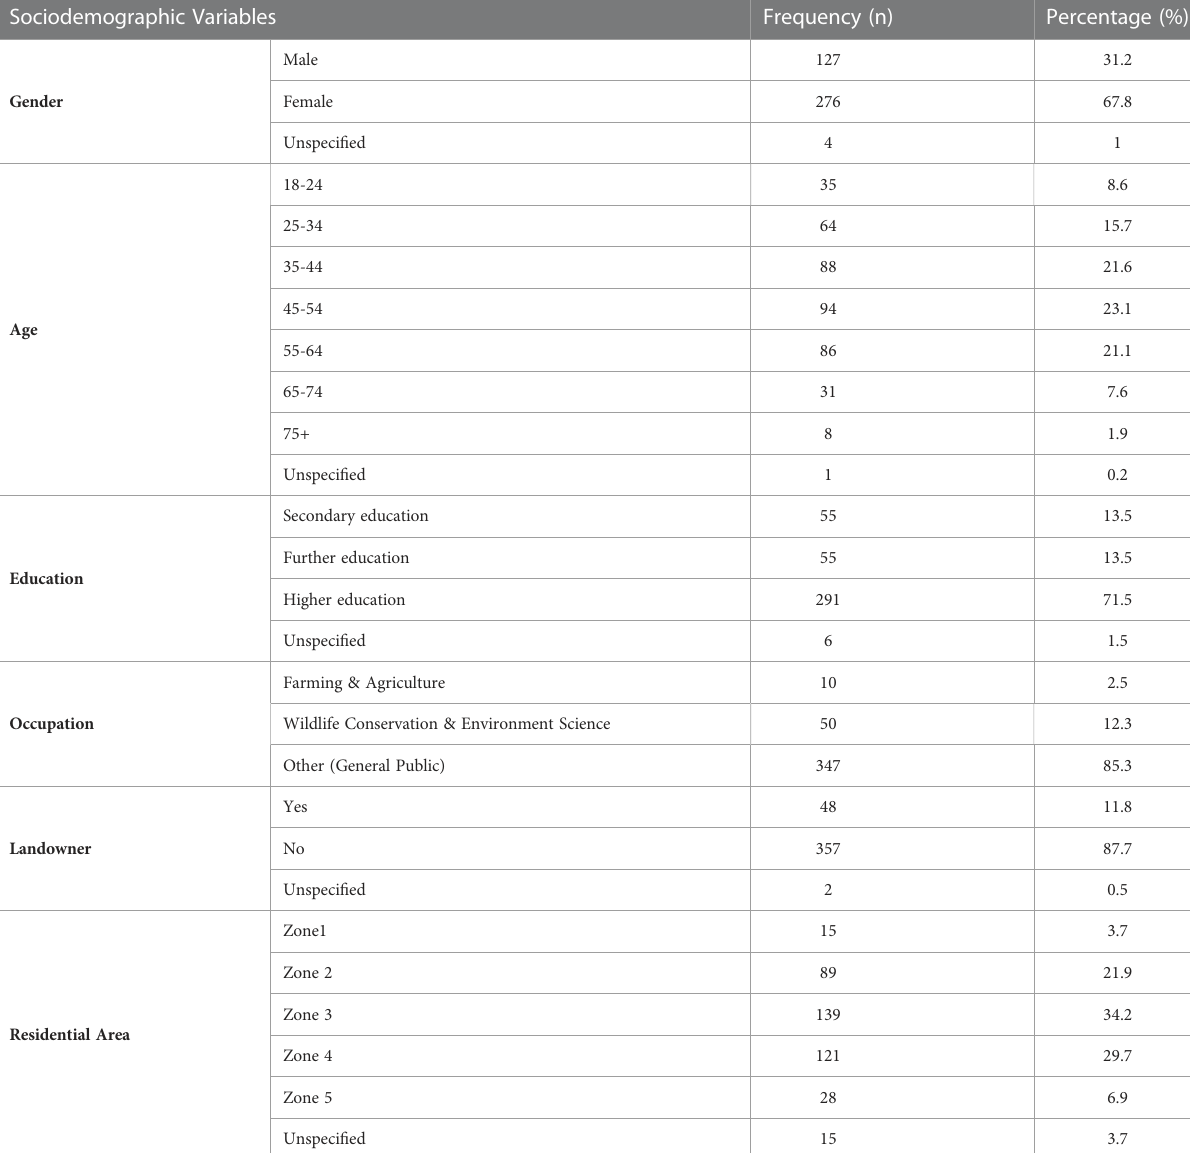
TABLE 1 Frequency and percentage of respondents ’ gender, age group, education level, occupation, landownership and residential area. Sociodemographic